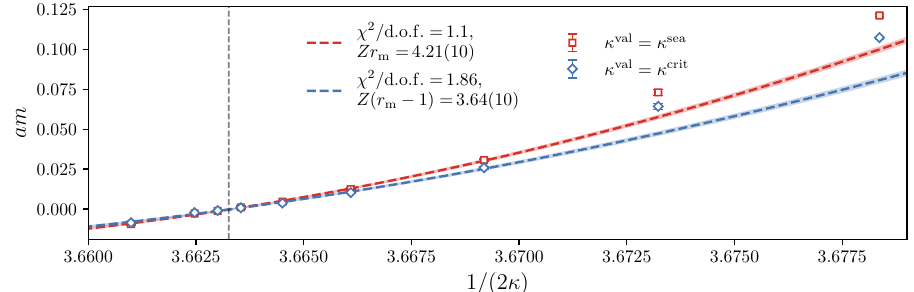
Fig. 4 PCAC masses am , at β = 3 . 3, fitted with a quadratic polyno- mialin1 /( 2 κ) .Squaresanddiamondsareresultsintheunitaryandnon- unitary setups, respectively. Note that the two rightmost points (A3k1, A3k3) are not included in the fit, while A3k2 (at 1 /( 2 κ) = 3 . 6692)